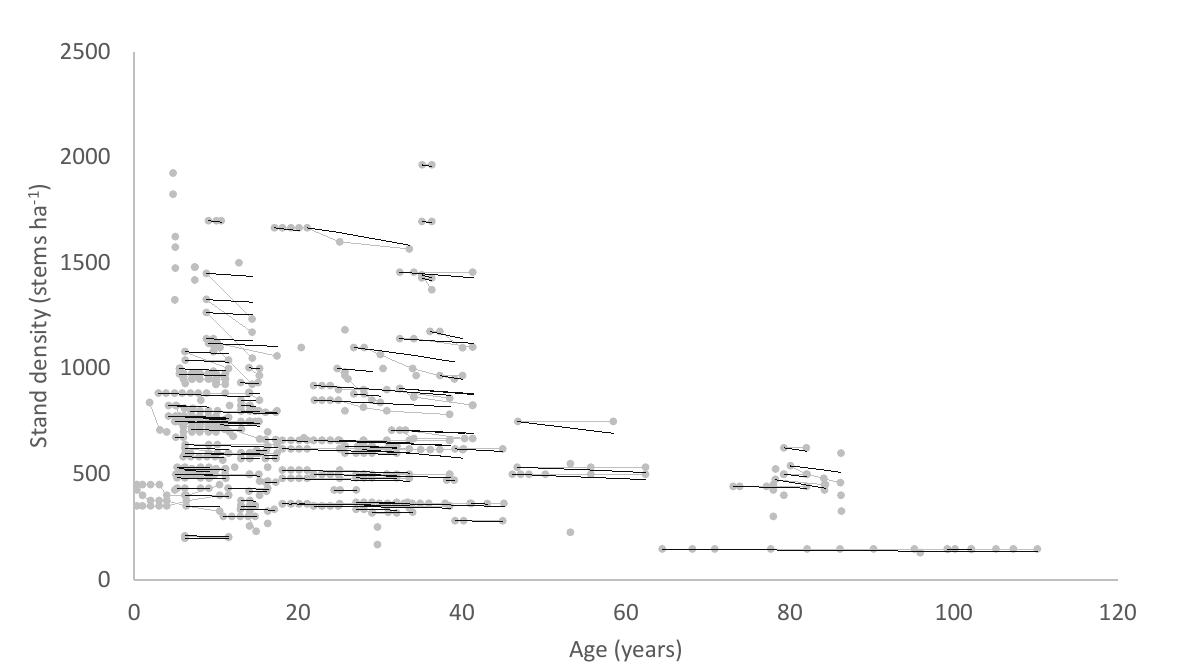
Figure 6. Mean stand density vs. age for the plot measurement database. Grey dots indicate measurements, with grey solid lines showing plots measured multiple times. Black lines show predictions from Equation (9) based on the initial measurement in each plot.